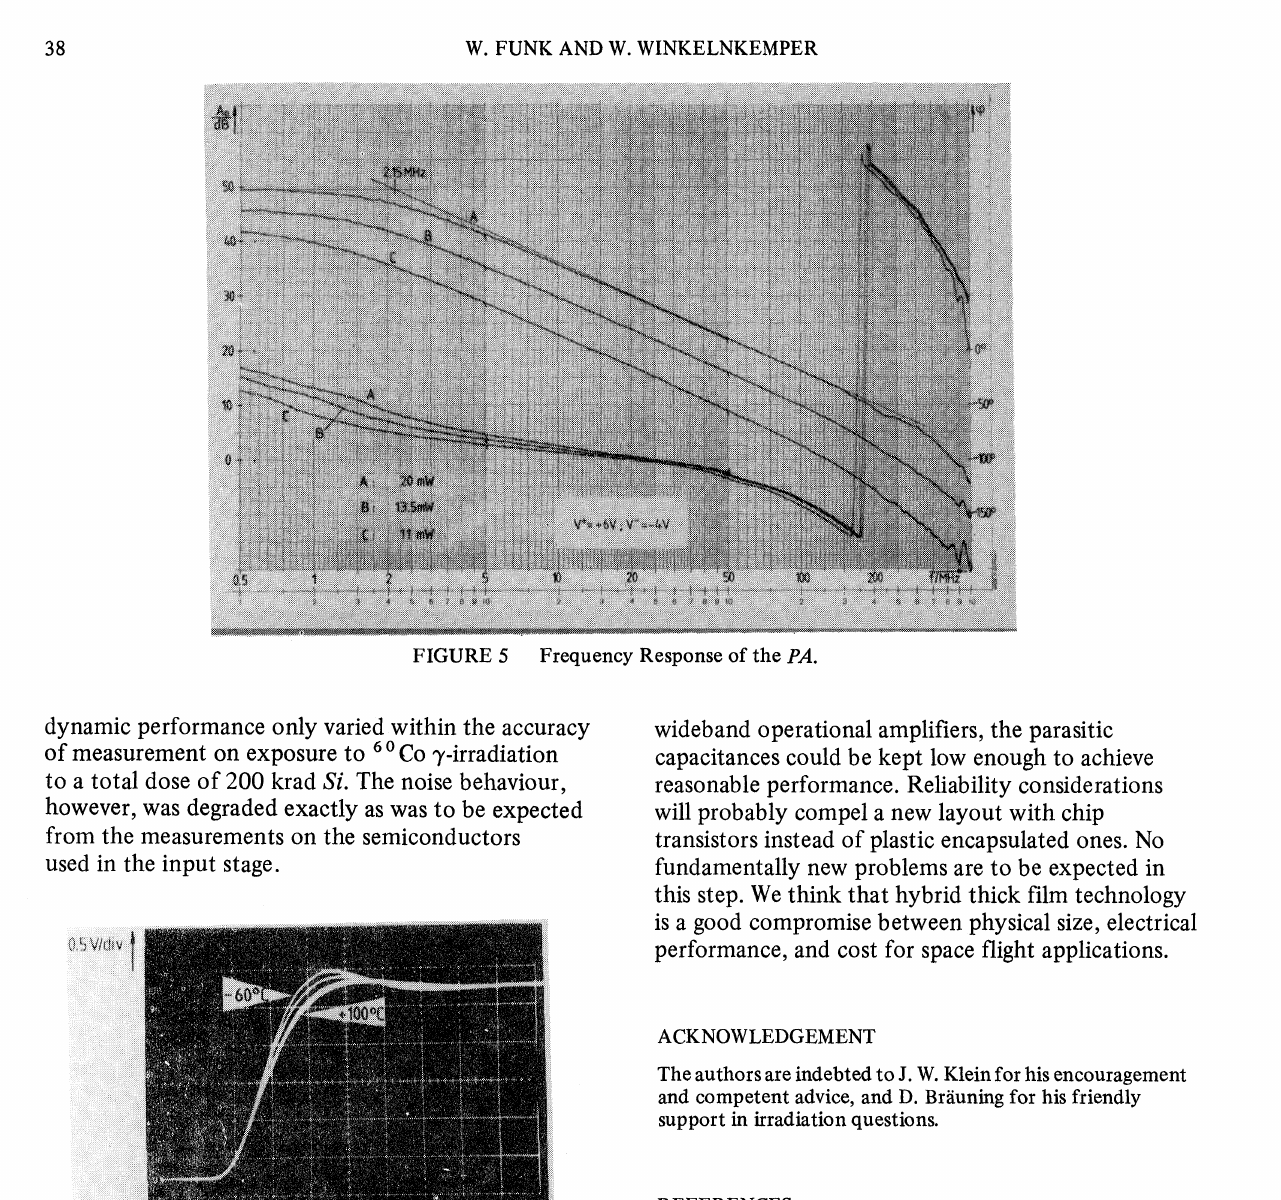
FIGURE 6 Step response variation over temperature of the